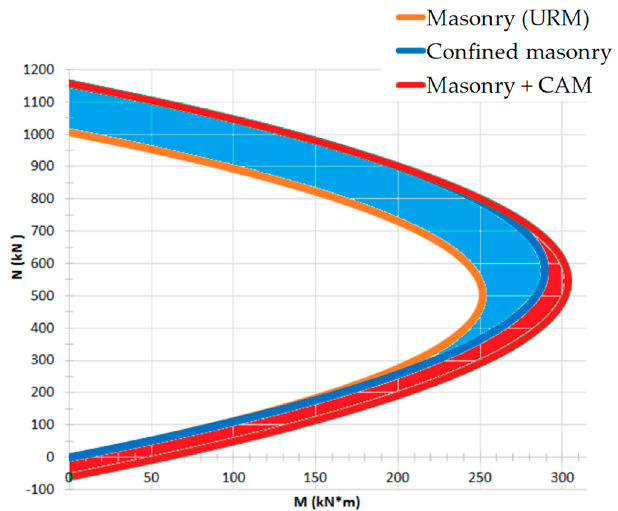
Figure 31. M ‐ N interaction domain for a masonry wall reinforced with the CAM system [67]. Figure 31. M-N interaction domain for a masonry wall reinforced with the CAM system